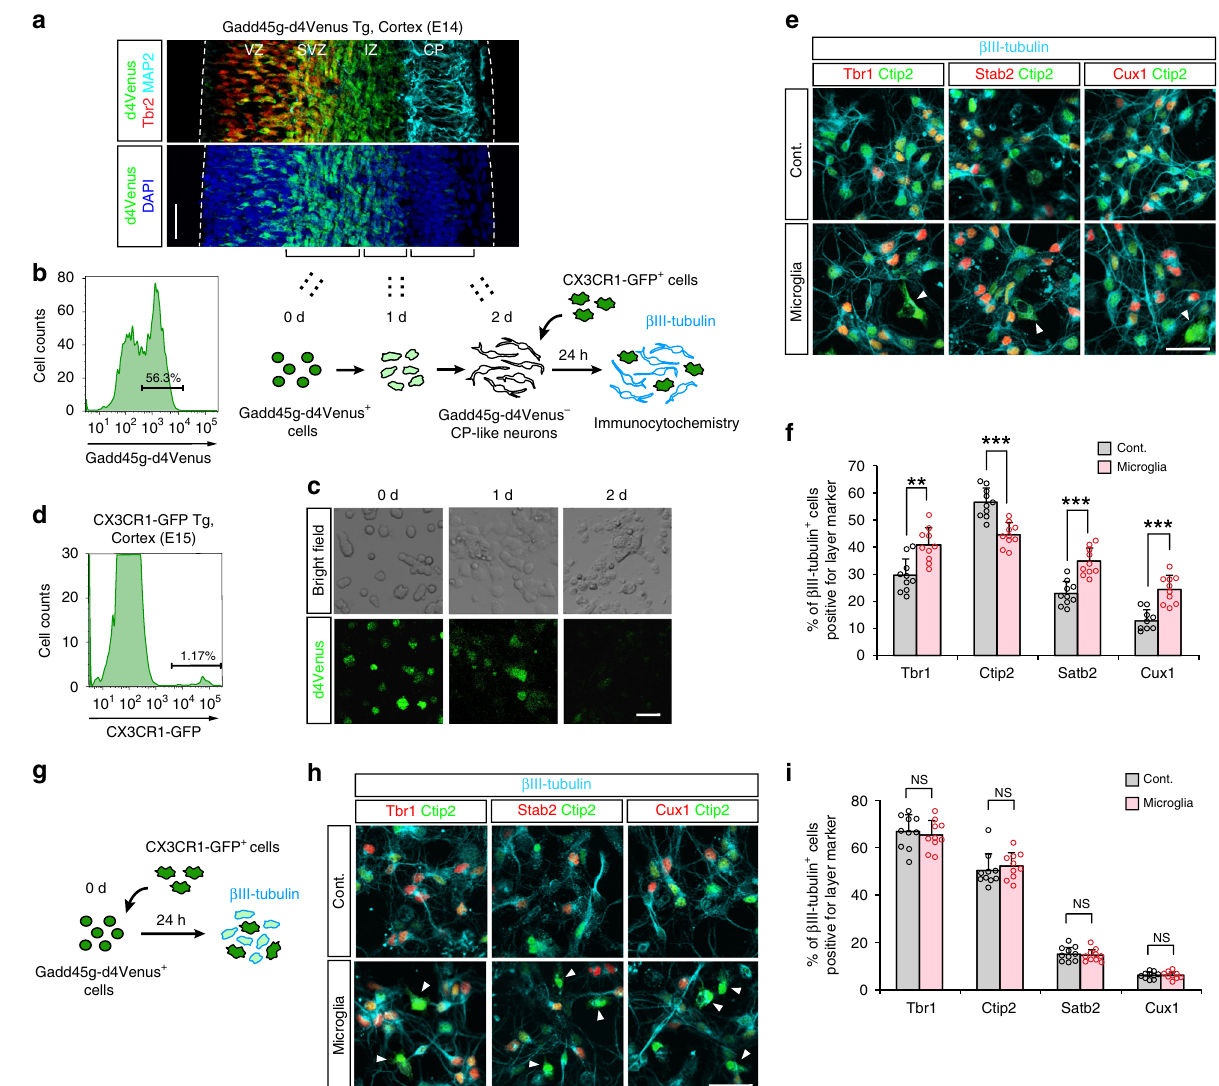
Fig. 5 In vitro-prepared CP-like neurons changed subtype marker expression upon exposure to microglia. a Immunostaining for d4Venus (Gadd45g; green), Tbr2 (red), MAP2 (cyan), and DAPI (blue) in E14 Gadd45g-d4Venus Tg mouse cerebral walls. The broken lines indicate apical and basal surfaces. Scale bar, 50 µ m. b The protocol for the in vitro preparation of CP-like neurons, which were obtained from Gadd45g-d4Venus + cells isolated from the E14 Gadd45g-d4Venus cortex by FACS, after culture for 2 days. c A time-lapse series showing the reduction in Gadd45g-dVenus expression during culture. Scale bar, 20 µ m. d CX3CR1-GFP + microglia harvested from E15 CX3CR1-GFP pallial walls by FACS were added to the CP-like neuronal cultures. e Representative immunostaining (shown in pseudo color) for β III-tubulin (cyan), Tbr1/Satb2/Cux1 (red), and Ctip2 (green). The arrowhead indicates microglia. Scale bar, 30 µ m. f The proportion of the β III-tubulin + cells that expressed Tbr1, Ctip2, Satb2, or Cux1 in cocultures with or without microglia (two-sided Mann – Whitney U test; n = 10 independent experiments; P = 0.0021 for Tbr1, P = 7.6 × 10 − 5 for Ctip2, P = 7.6 × 10 − 5 for Satb2, P = 1.5 × 10 − 4 for Cux1). g An experimental schematic of the coculture of youngest (0 day, Gadd45g-d4Venus + ) neurons and CX3CR1-GFP + microglia. h Representative immunostaining (shown in pseudo color) for β III-tubulin (cyan), Tbr1/Satb2/Cux1 (red), and Ctip2 (green). The arrowhead indicates microglia. Scale bar, 30 µ m. i The proportion of β III-tubulin + cells that expressed Tbr1, Ctip2, Satb2, or Cux1 in cocultures with or without microglia (two-sided Mann – Whitney U test; n = 10 independent cultures; P = 0.529 for Tbr1, P = 0.289 for Ctip2, P = 0.631 for Satb2, P = 0.912 for Cux1). Data are presented as the mean values ± S.D. Source data are provided as a Source Data